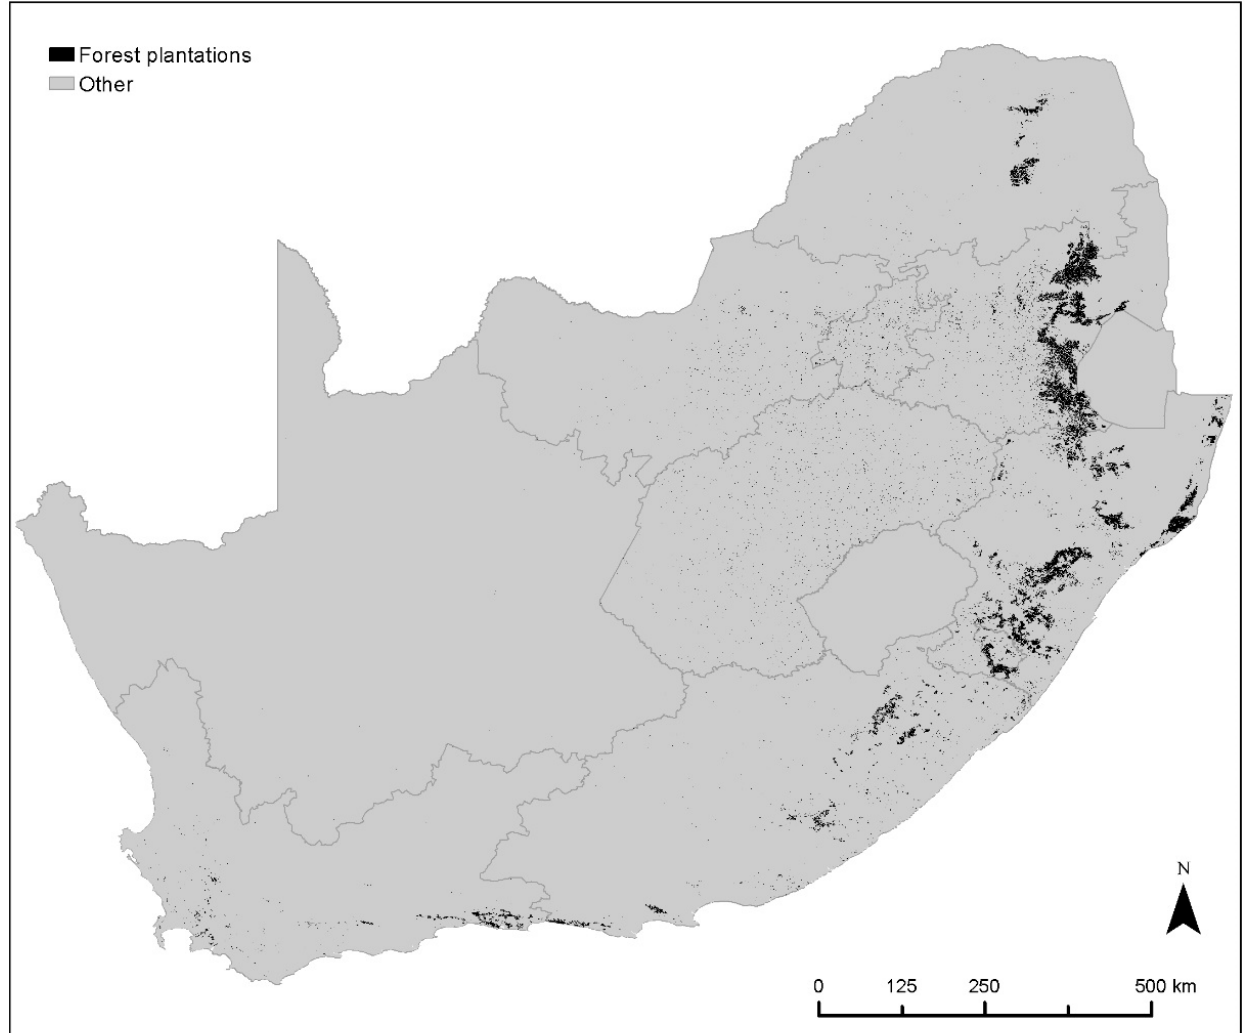
Figure 1. Distribution of South African forest plantations (DAFF 2008).